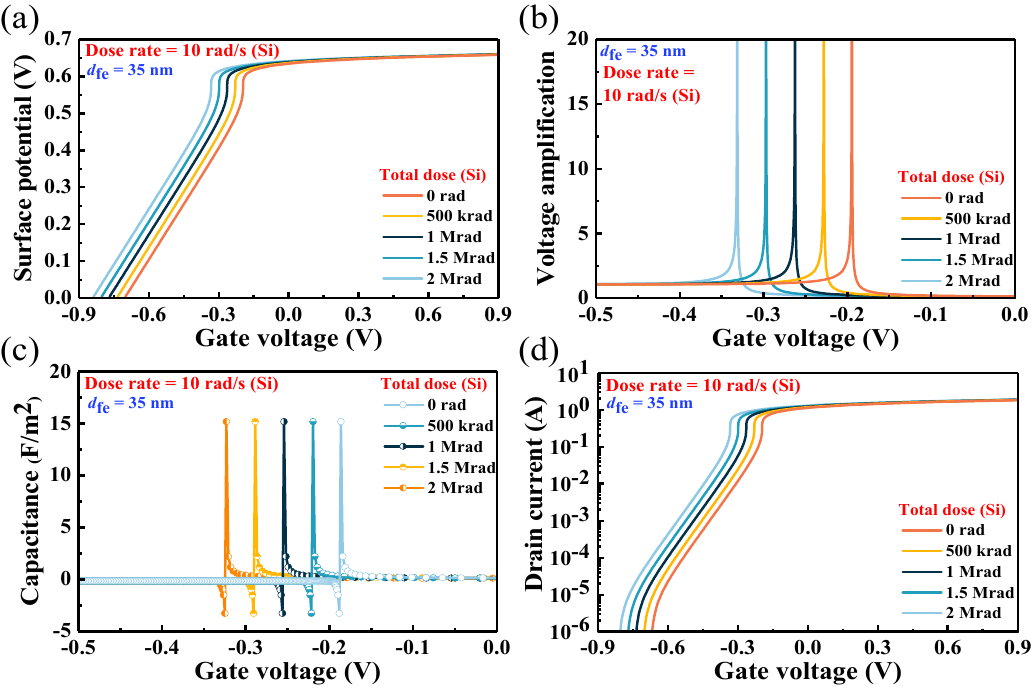
Figure 2. (Color online) ( a ) Silicon surface potential versus gate voltage; ( b ) voltage gain versus gate voltage; ( c ) ferroelectric capacitance versus gate voltage; ( d ) transfer characteristics with different total doses.